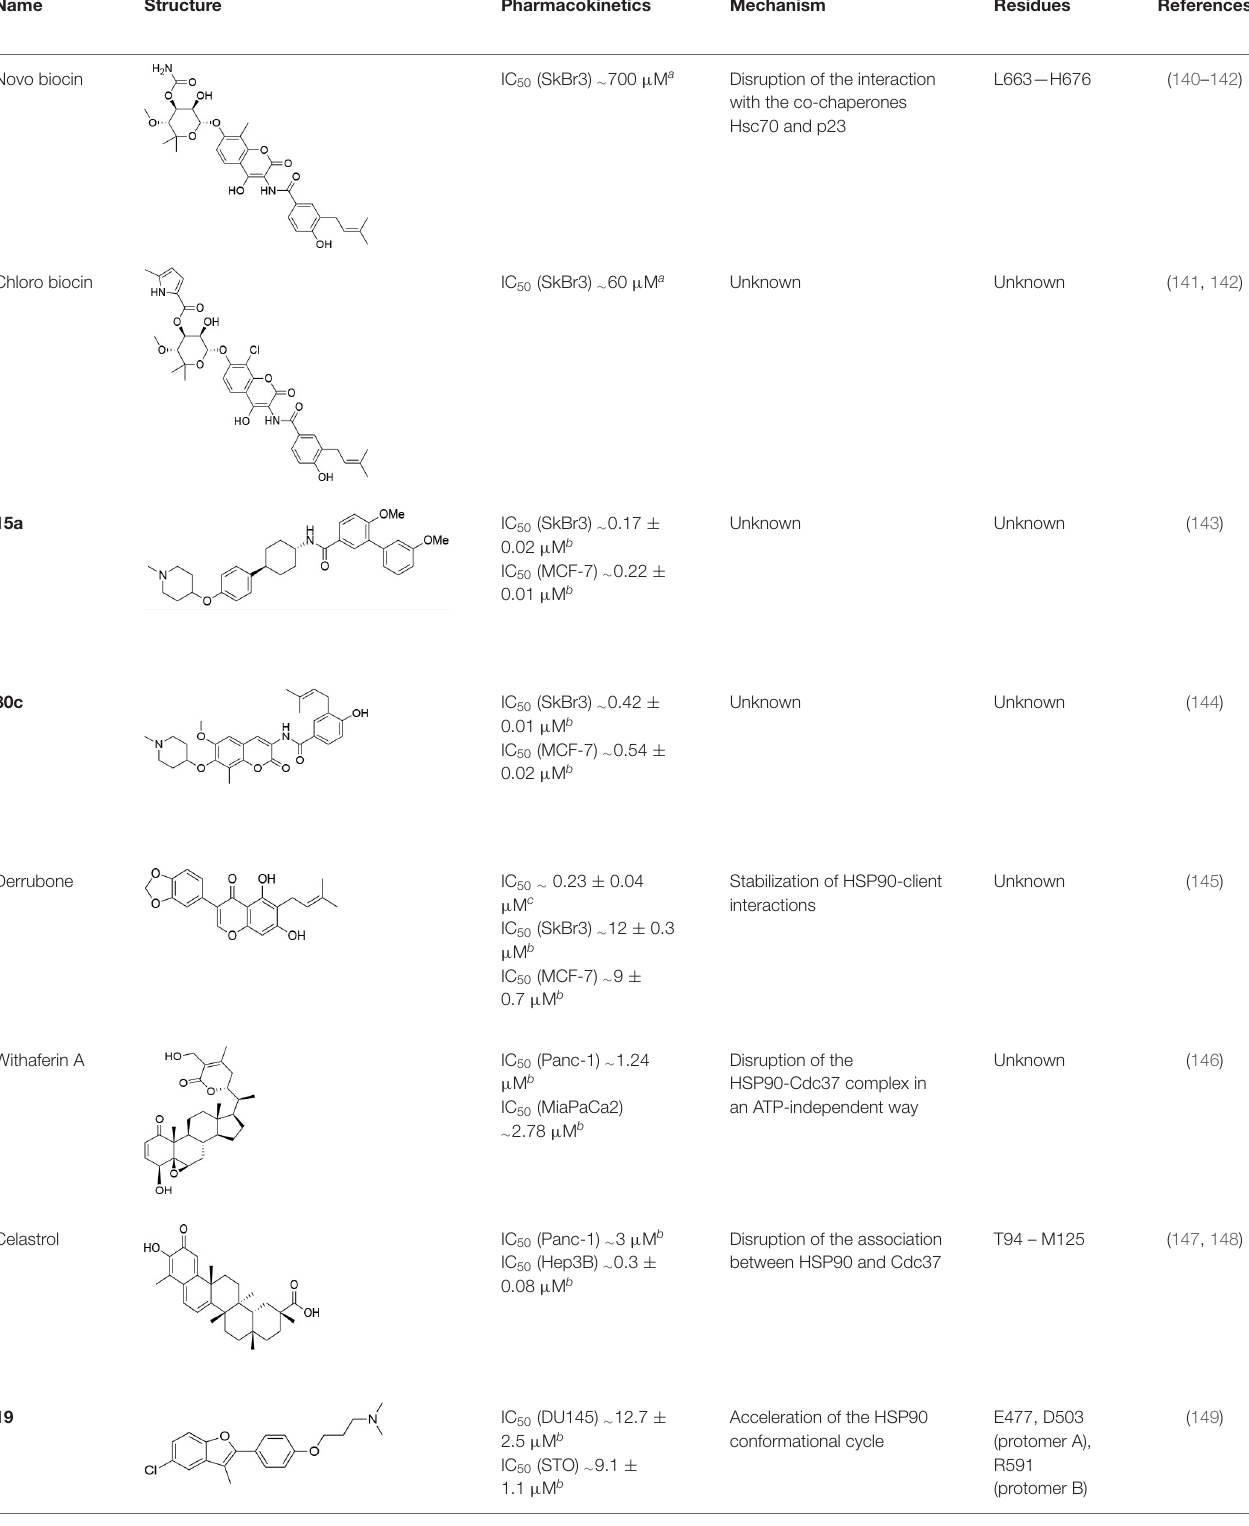
TABLE 4 | Summary of the most important compounds identified as allosteric modulators of